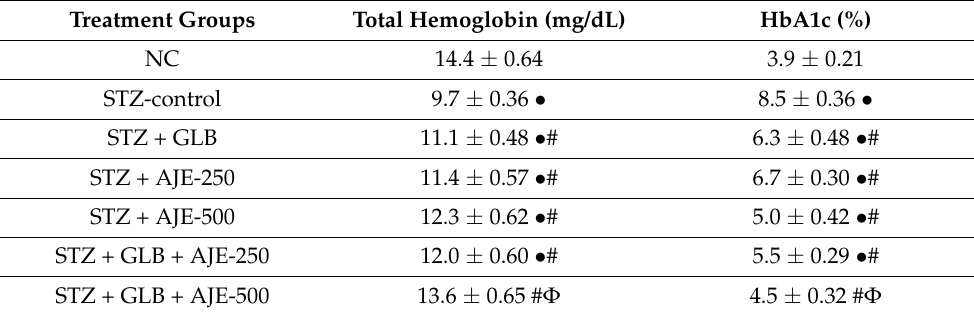
Table 5. Effect of GLB, AJE, and their combination on blood levels of total Hb and HbA1c in STZ-diabetic rats after 8 weeks of the medication